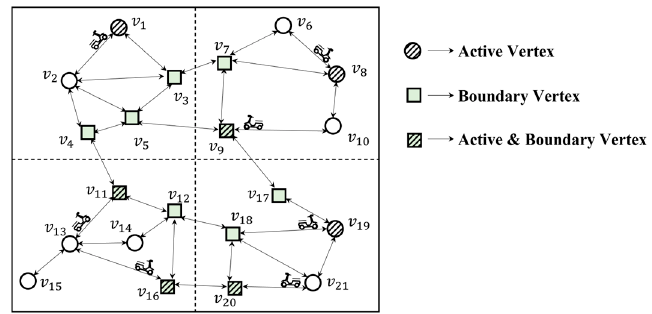
Figure 4. Schematic diagram of active and boundary vertices.